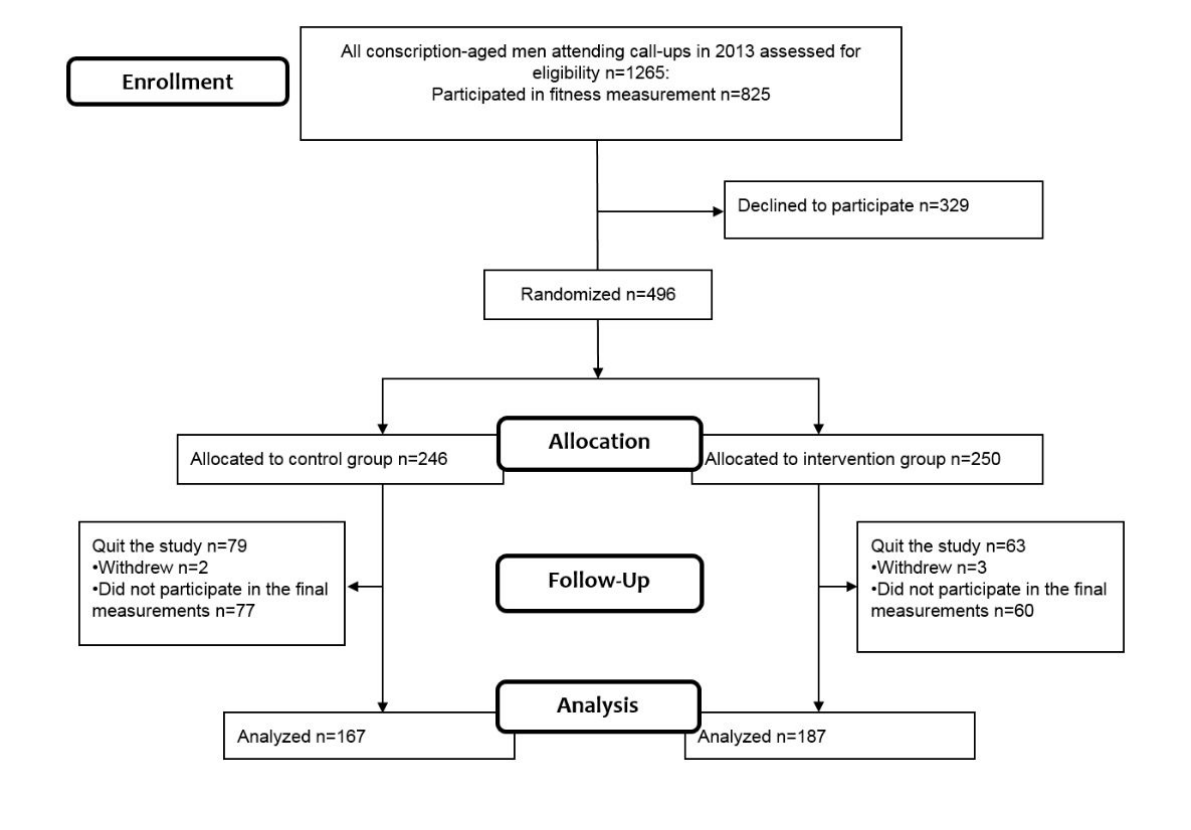
Figure 1. The flow diagram of participants in the 6-month randomized controlled MOPO study.